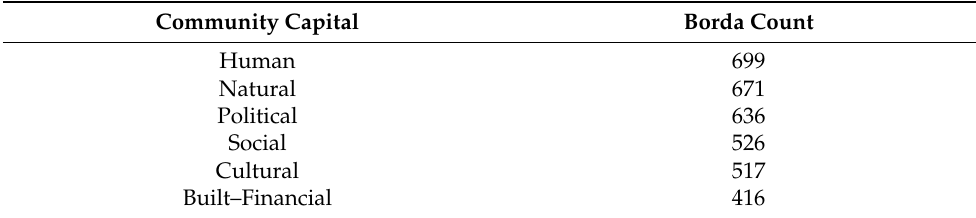
Table 3. Community Capital Borda Counts. Table 4 depicts the weighted rankings for each community capital. Human capital was associated with the highest weighted ranking score. Cultural capital was associated with the lowest weighted ranking